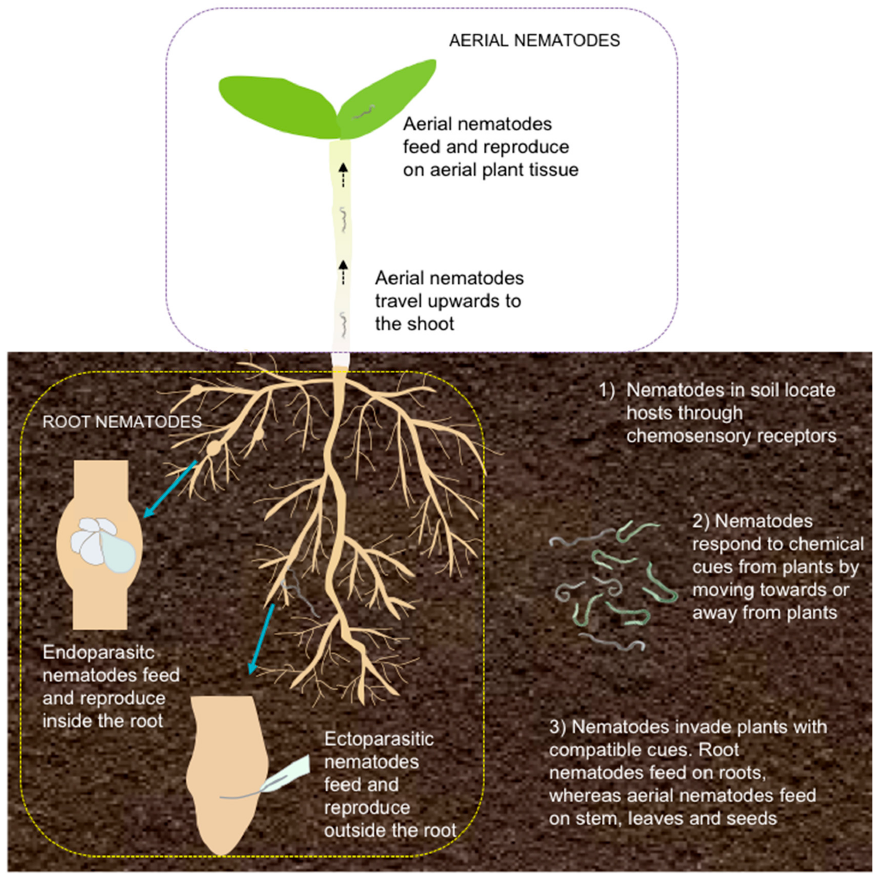
Figure 1. Summary of interactions between plant hosts and plant-parasitic nematodes. Plant hosts are infected by both root and aerial nematodes. Their interaction starts in the soil with the perception of host cues by the nematode, followed by attraction or repulsion towards or away from the host. Root nematodes include ecto- and endoparasites, with endoparasites causing the greatest damage due to their induction of a complex feeding site, in which they reproduce.